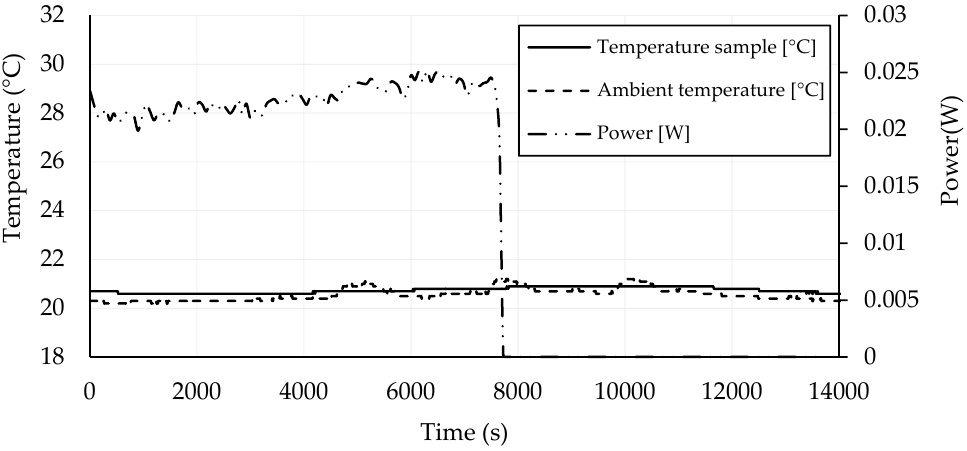
Figure 3. Self-heating experiment—CB 0, 40 V.